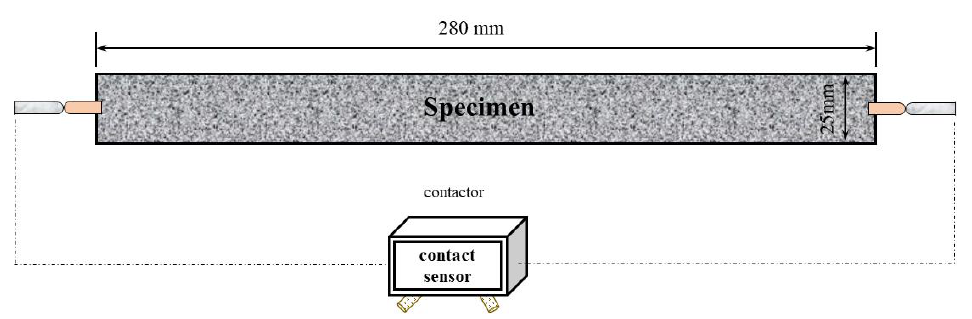
Figure 7. Schematic diagram of autogenous test.